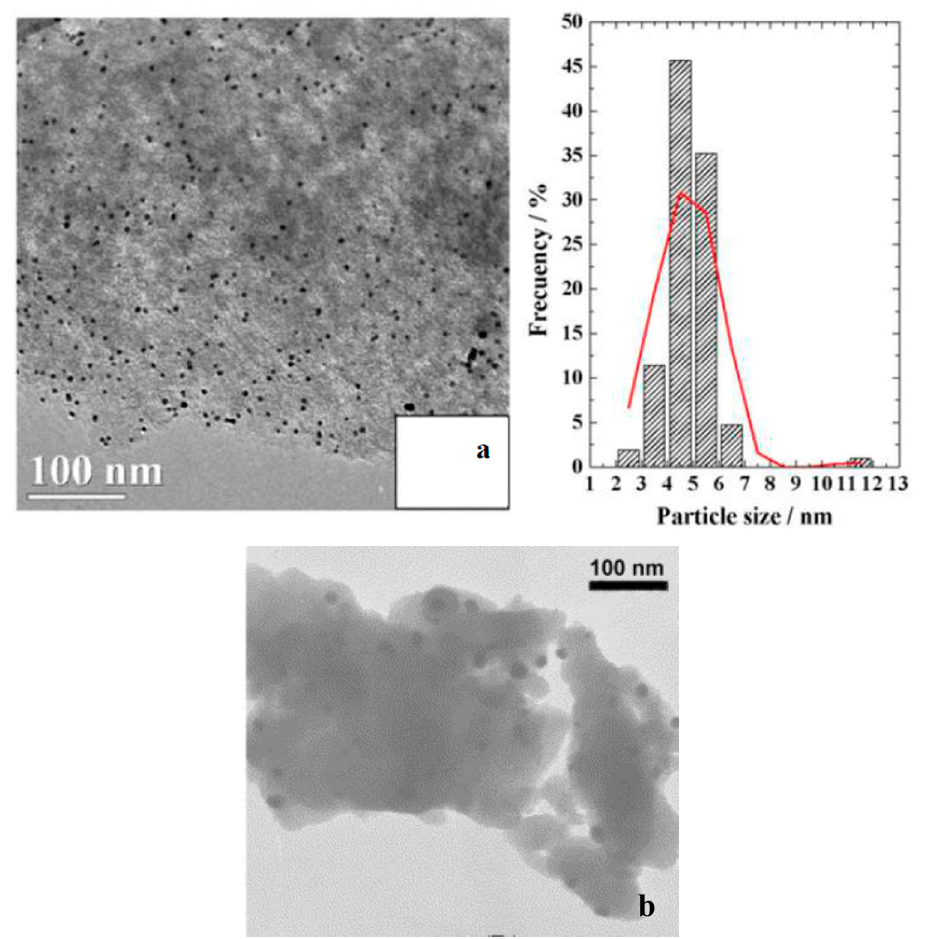
Figure 4. ( a ) TEM image and particle size distribution of Au / C prepared by the sol immobilization method (dried at 60 ◦ C until total evaporation of solution) and ( b ) TEM image of Au / Y prepared by ion-exchange at 25 ◦ C and pH = 5.0. Gold nanoparticles are seen as dark spots. Adapted from Quintanilla et al. [68] and Lin et al. [89], respectively.